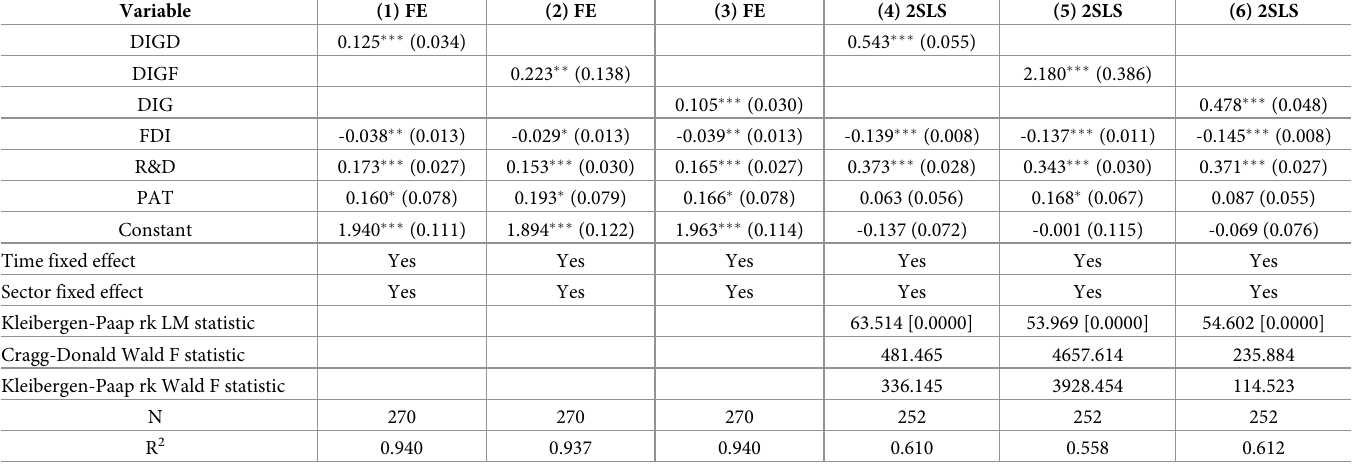
Table 4. Robustness test